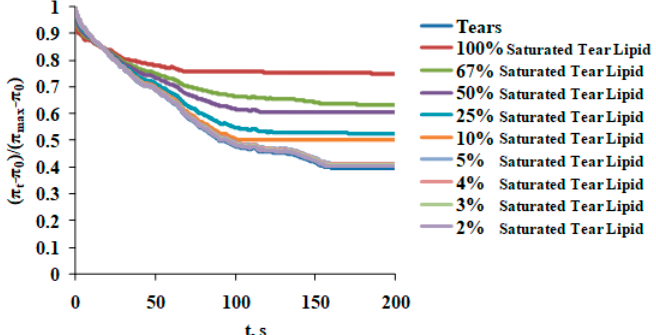
Figure 7. Increase in catalytic saturation shifts the surface pressure relaxation transients to higher surface pressures (a manifestation of increased elasticity). The shape of the transients is complex and reflects the composite composition of the tear layers. The 2% to 5% saturated samples’ transients are identical to the one of native tears. The rest of the transients were subjected to Fourier transformation analysis and the results are summarized in Figure 8.